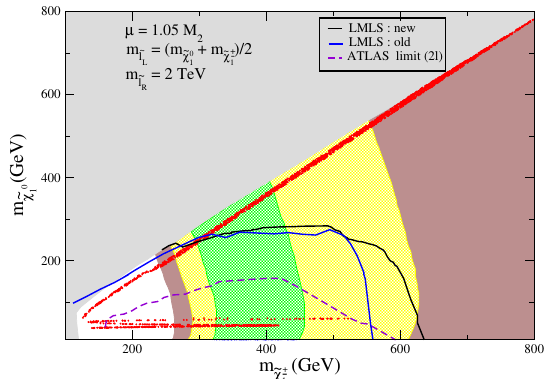
Figure 5 . Plot in m (cid:0) m plane in Light Mixed and light Left Slepton (LMLS) model. The (cid:6) e (cid:31) 0 1 e (cid:31) 1 black contour is for the non-decoupled scenario whereas the blue one is for the decoupled scenario (see text for details). Magenta dashed line represents the exclusion contour from ATLAS slepton searches. Colors and conventions are same as in (cid:12)gure